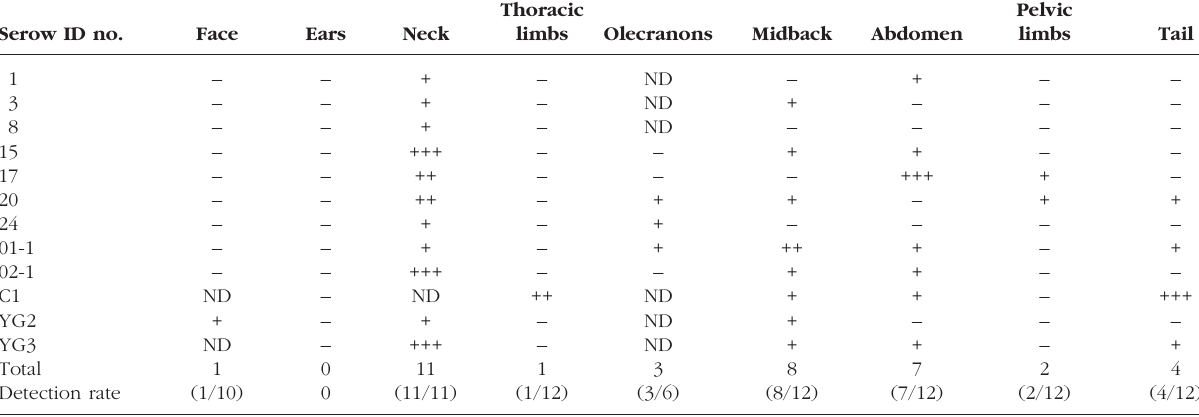
Table II. – Distribution of microfilariae of Loxodontofilaria caprini n. sp. in skin snips of Japanese serows with such